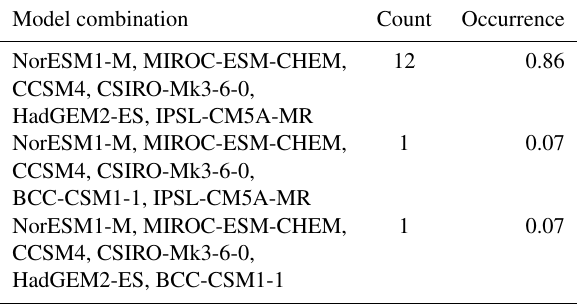
Table C3. Possible model combinations for the Antarctica top six selection, with absolute and relative frequency of occurrence when applying the robustness